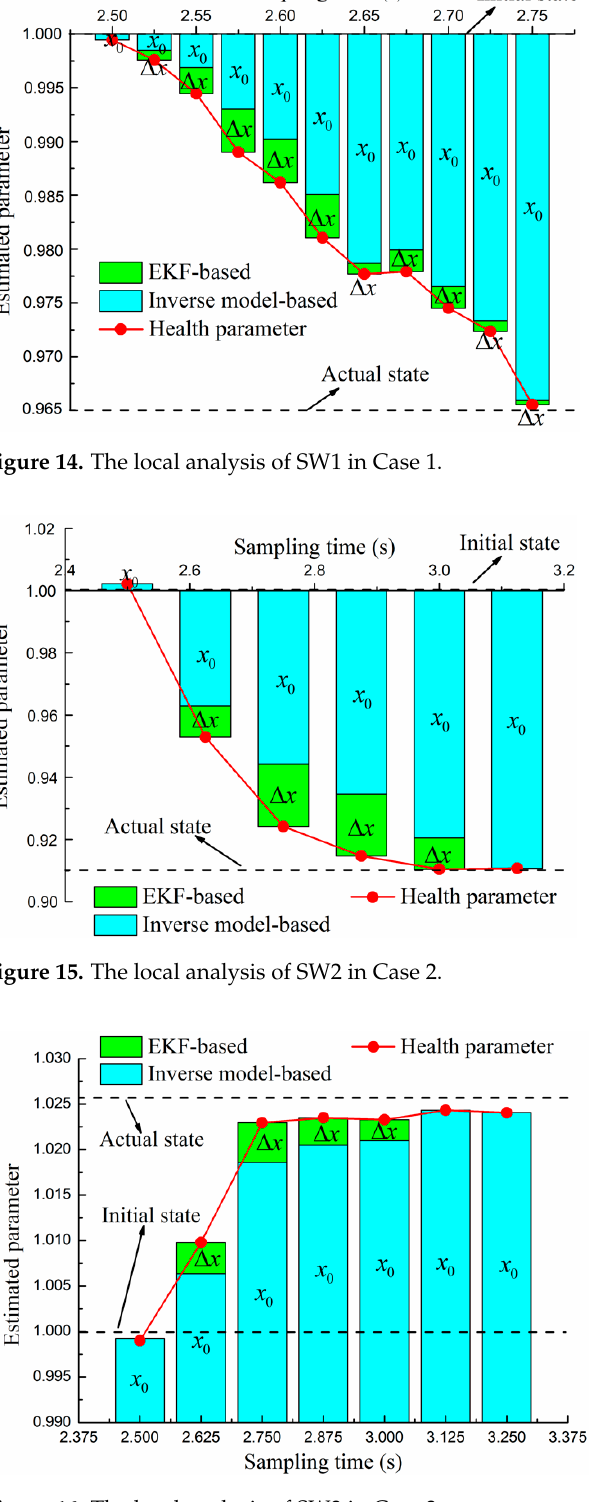
Figure 16. The local analysis of SW3 in Case 3.